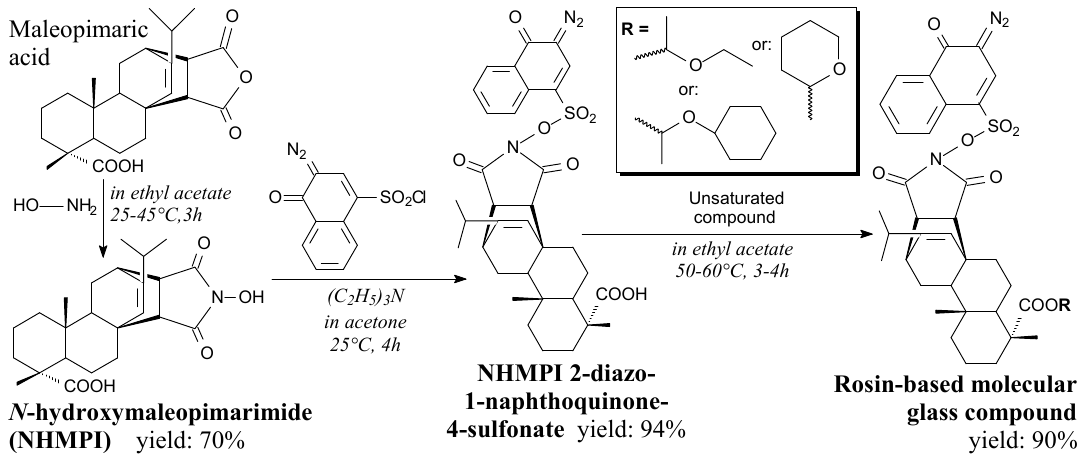
Scheme 52. Synthesis of rosin-based molecular glass compound.